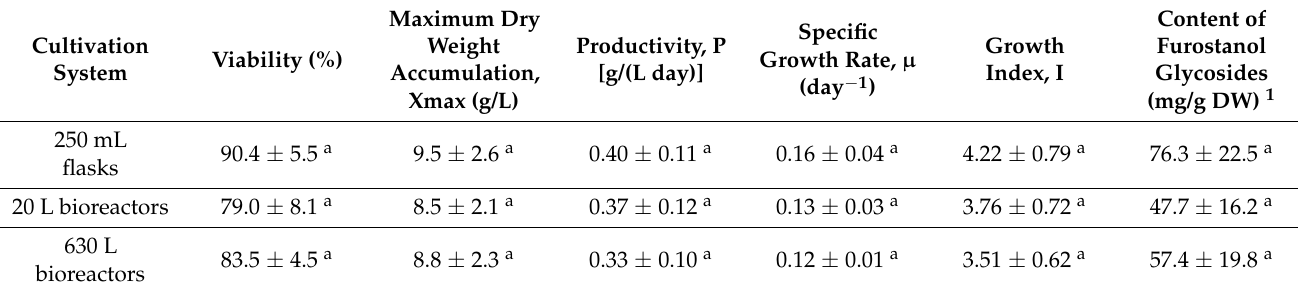
Table 1. Growth Characteristics and Content of Furostanol Glycosides in Dioscorea deltoidea Suspension Cell Culture Grown in Flasks and